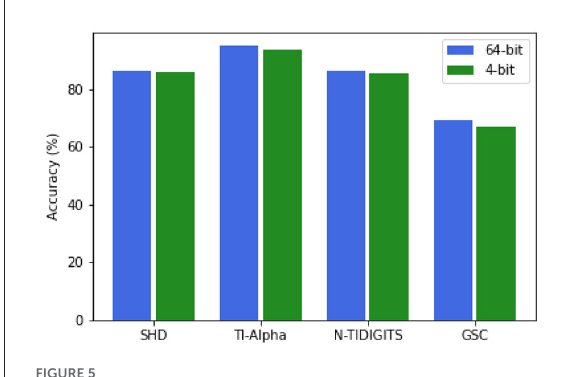
FIGURE5 Recognition performance comparison on the test set between full 2000-neuron ELSM model (64-bit) and the lower resolution model (4-bit) across the selected data